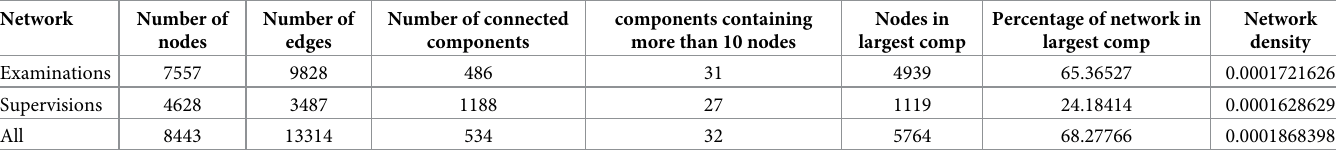
Table 1. Summary of key network statistics for primatology toy model including, number of disconnected components, size of largest connected component and network